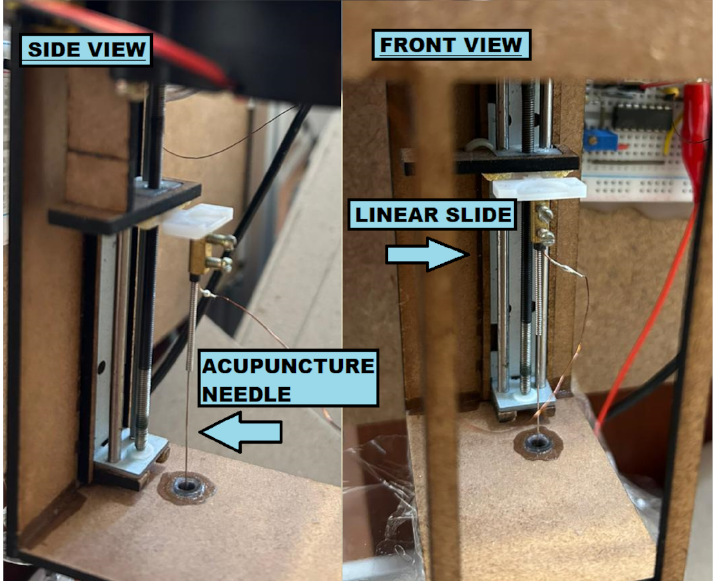
Figure 2. Water level sensor without the plastic protection cover: side and front views. The linear slide controls an acupuncture needle connected to a thin copper wire to detect the fluid level